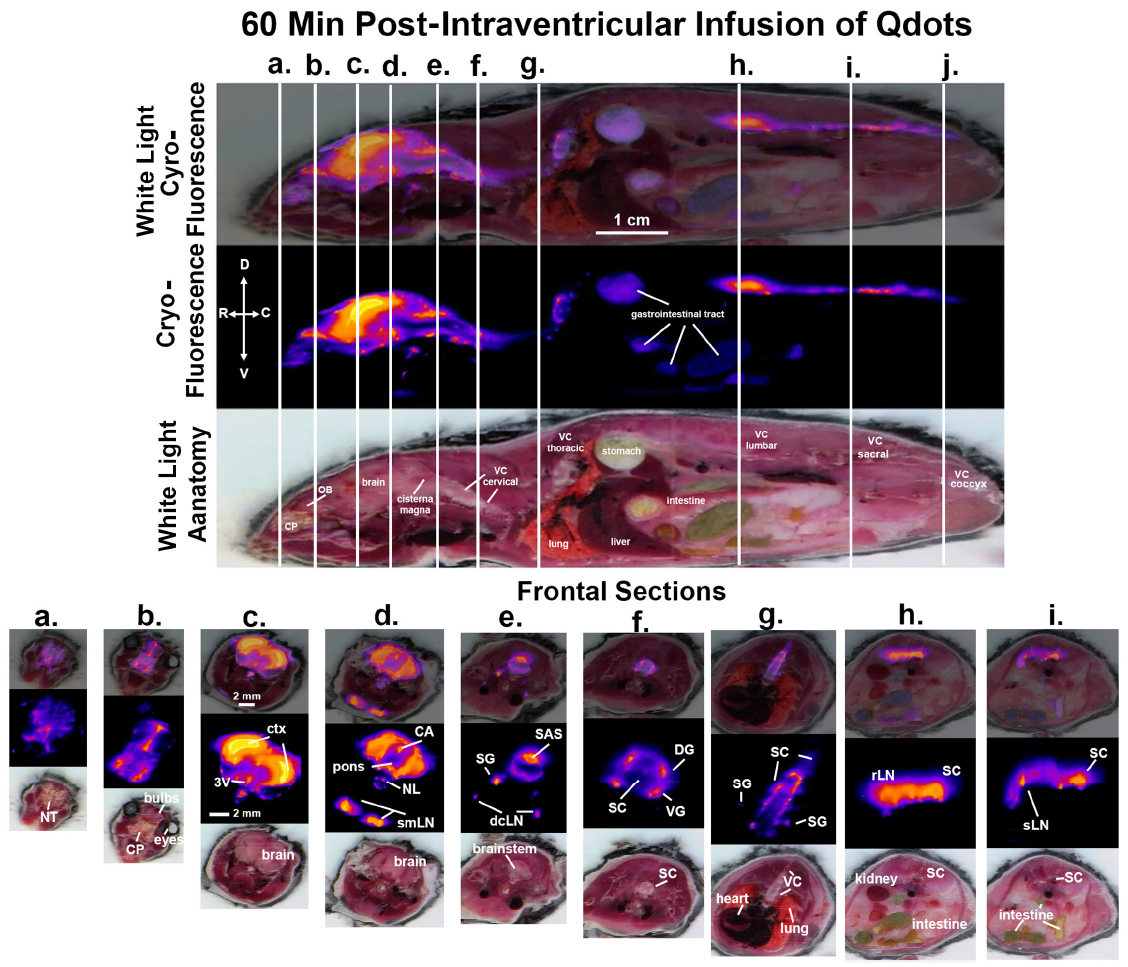
Figure 3. CNS distribution and clearance at 60 min. Shown above are sagittal sections depicting the same mouse imaged for white light anatomy, cryo-fluorescence, and both together at 60 min post infusion of ICV Qdots. The perpendicular white lines labeled ( a. – i. ) denote the position of the frontal